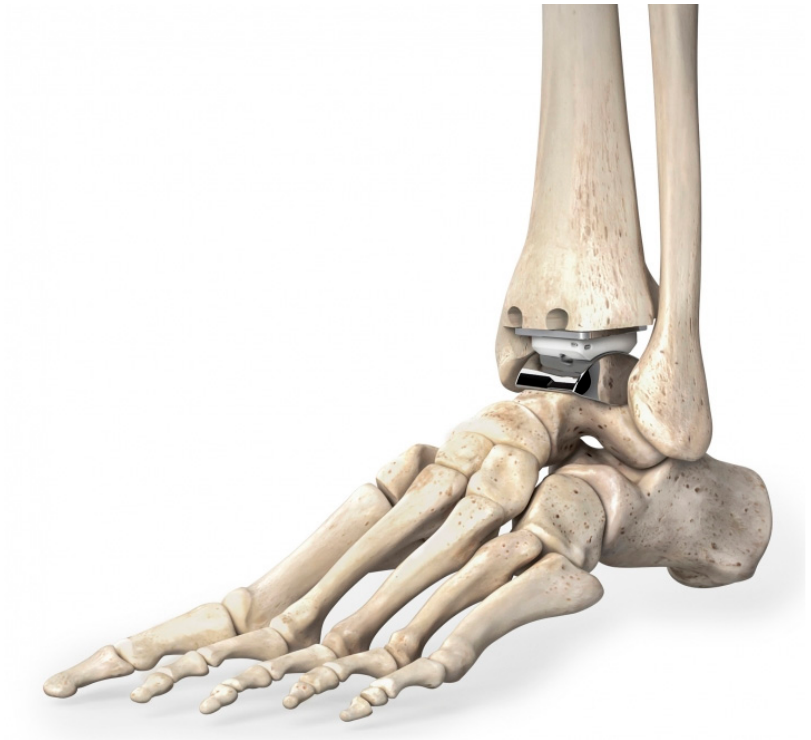
Figure 4. STAR ankle prosthesis rendering in the foot.